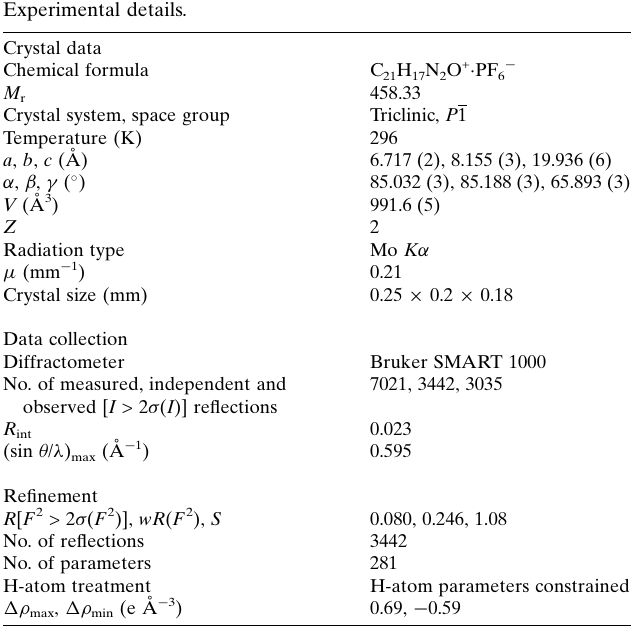
Table 2 Experimental details. Crystal data Chemical formula